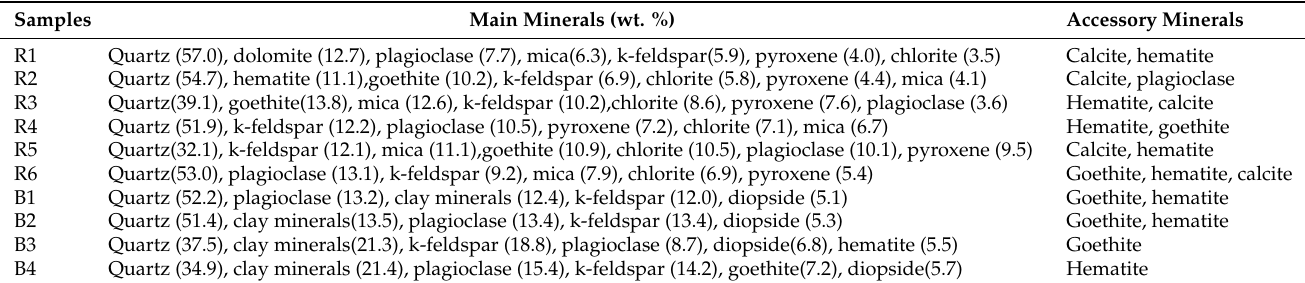
Table 3. Mineral composition of Kosva River and Kosva Bay sediments samples.